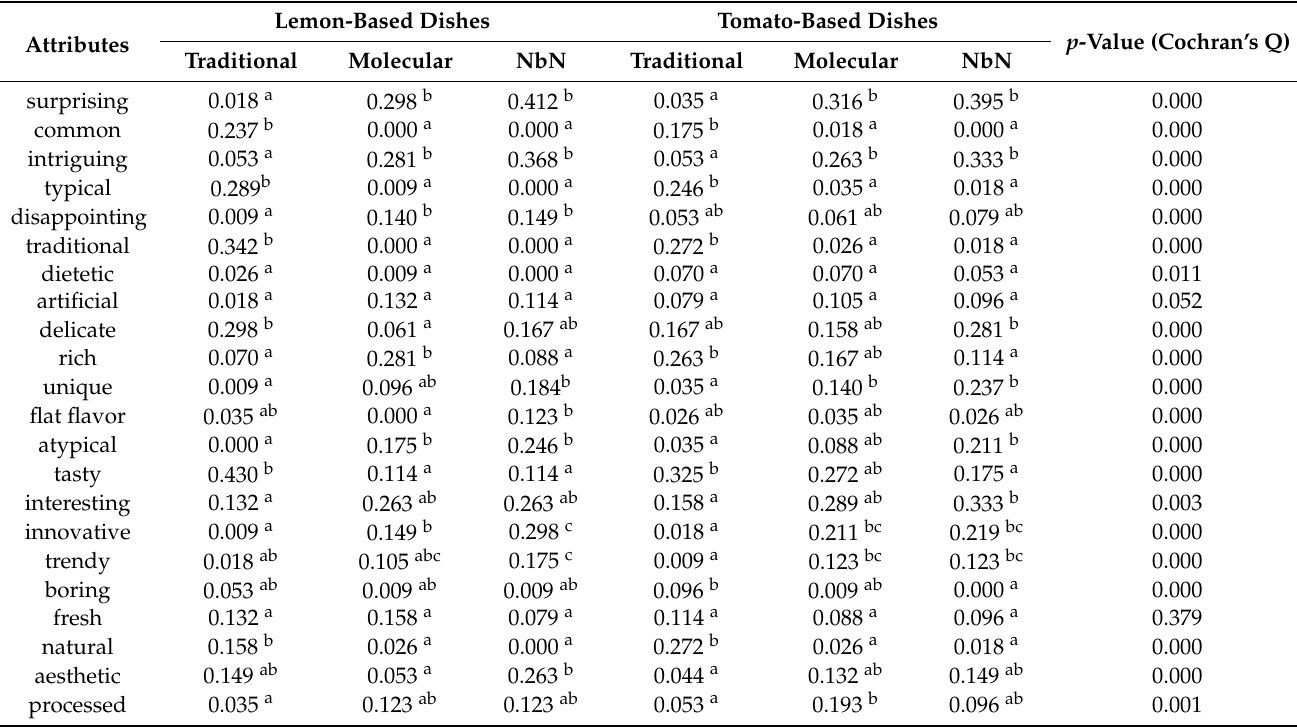
Table 4. A contingency table of data set with 6 products and 22 emotional attributes of the CATA